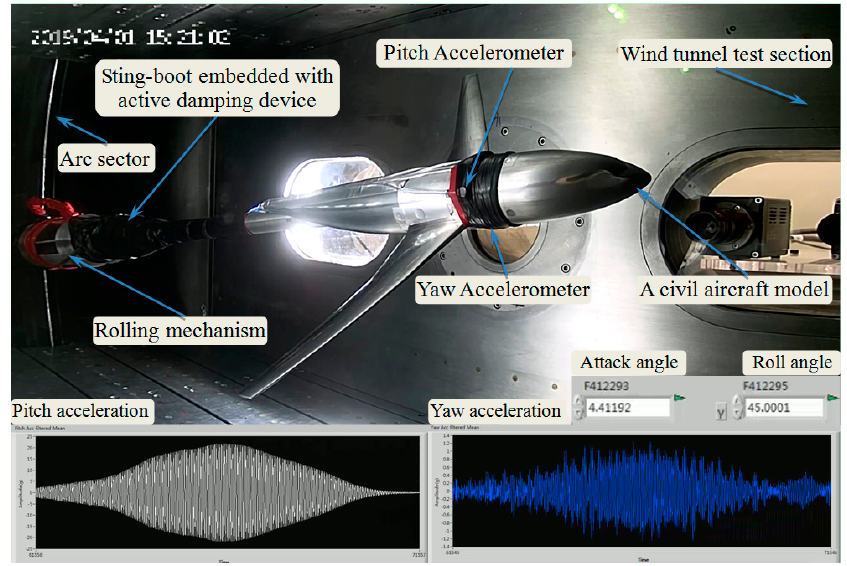
Figure 10. Photograph of the multidimensional vibration suppression system installed in a continuous transonic wind